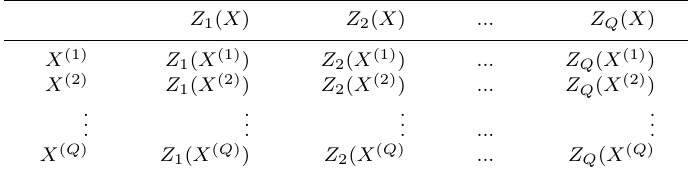
Table 1. Pay-off